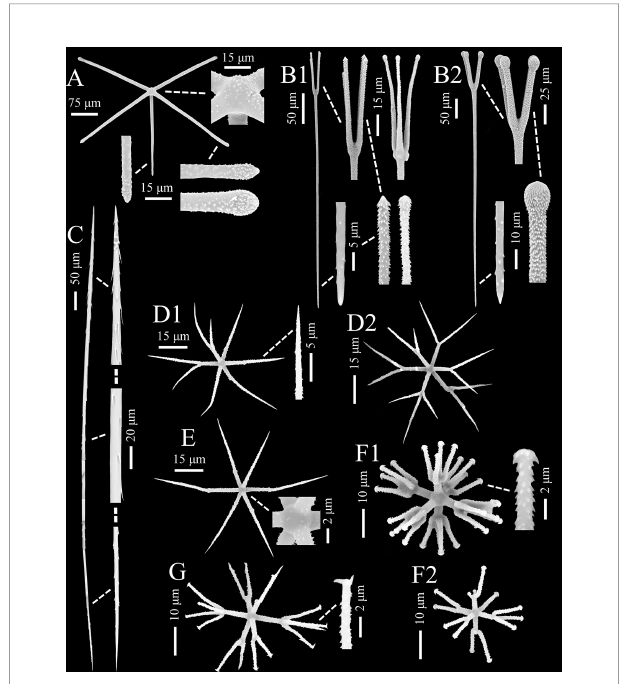
FIGURE 4 | Chonelasma tyloscopulatum sp.nov.,spicules ofholotype (SEM). (A) Surface pentactin, wholeand enlarged ray ends and cross center. (B) Two types of scopules, whole andenlarged headsand tips. (C) Uncinate, wholeand enlargedtips and center. (D) Hemioxyhexaster (D1) and oxyhexaster (D2) , whole andenlarged ray end. (E) Oxyhexactin, whole and enlarged cross center. (F) Discohexaster (F1) and hemidiscohexaster (F2) , wholeandenlarged secondary ray end. (G) Onycho-tipped hexaster,wholeand enlargedsecondary ray